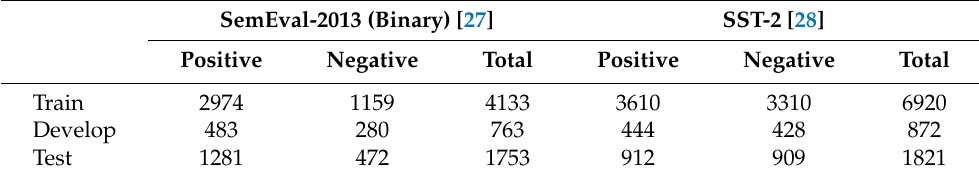
Table 2. The details of SemEval-2013 and SST-2 datasets.